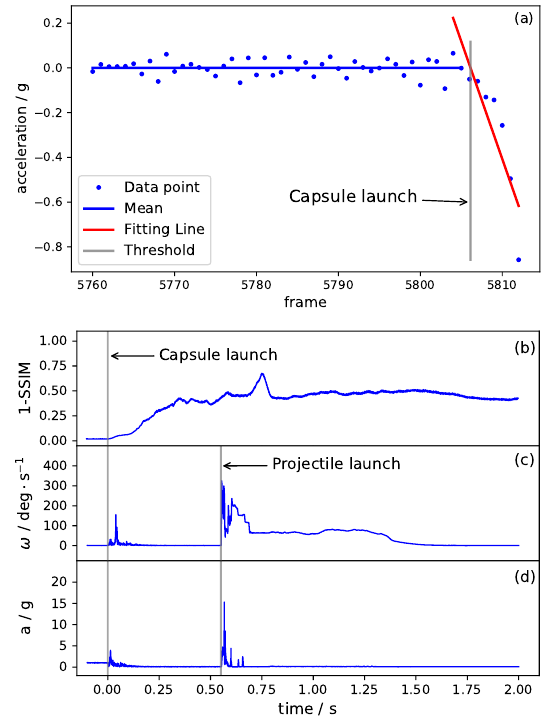
Figure 3. (a) Sample acceleration data showing how capsule launching time is obtained (see text for details). (b)-(d) Content change in subsequent images measured with structure similarity index measure (SSIM), magnitude of angular velocity and ac- celeration as a function of time with the capsule and projectile launching time marked respectively.